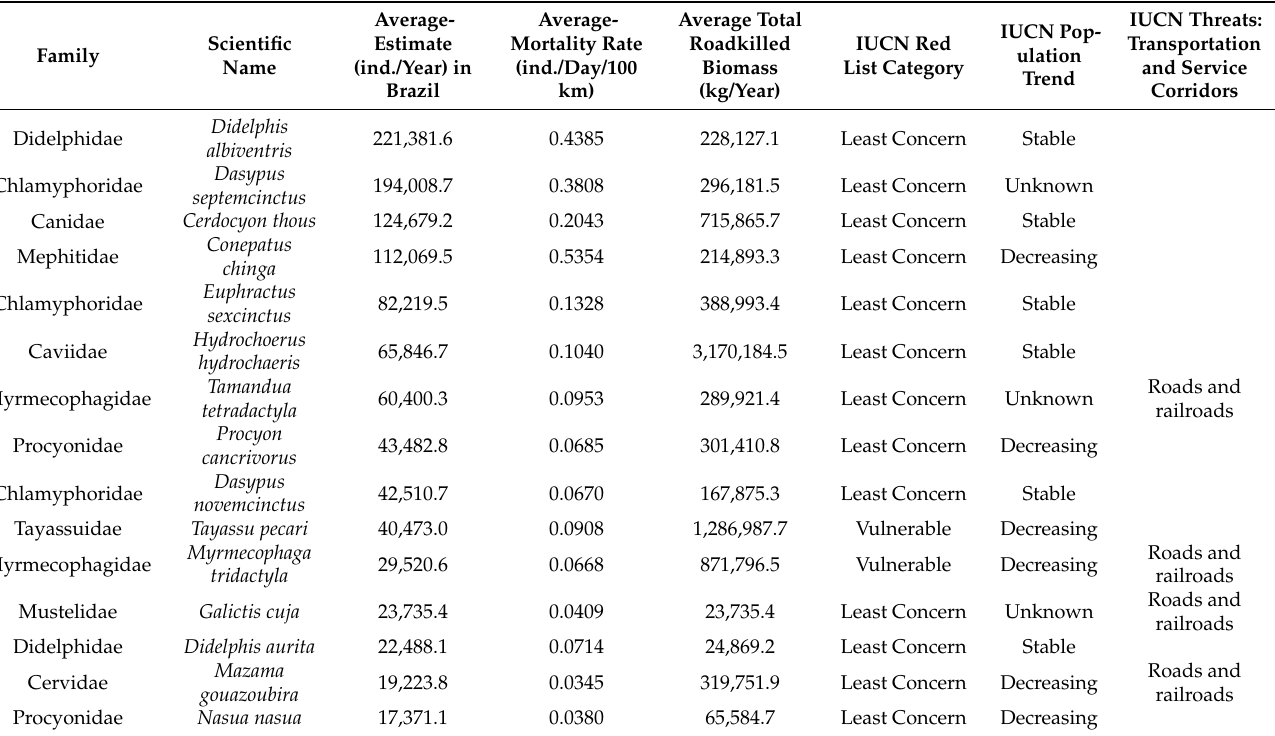
Table 1. Top 15 species with estimated average individuals and road-kill rates, conservation status, and threats (ranked by